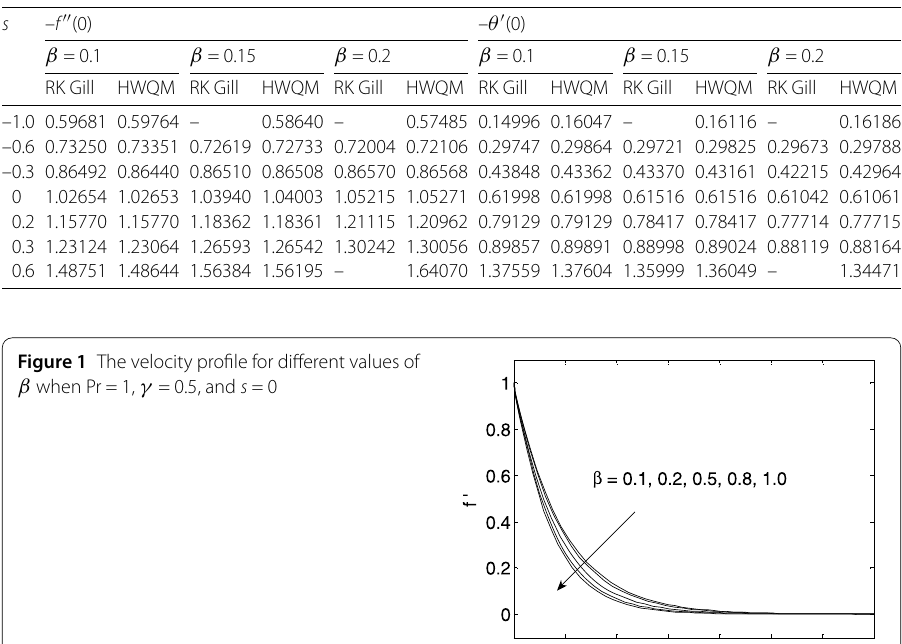
Table 3 The values of – f (cid:5)(cid:5) (0) and – θ (cid:5) (0) for different values of β and s when Pr = 1 and γ = 0.5